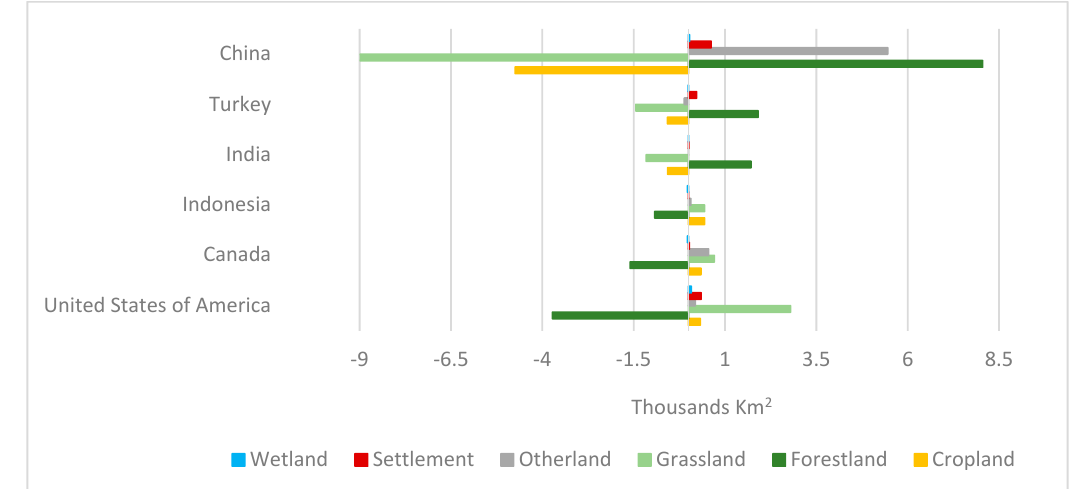
Figure 10. Gain and loss of land cover classes in mountain areas in countries where MGCI decreased from 2015 to 2018.